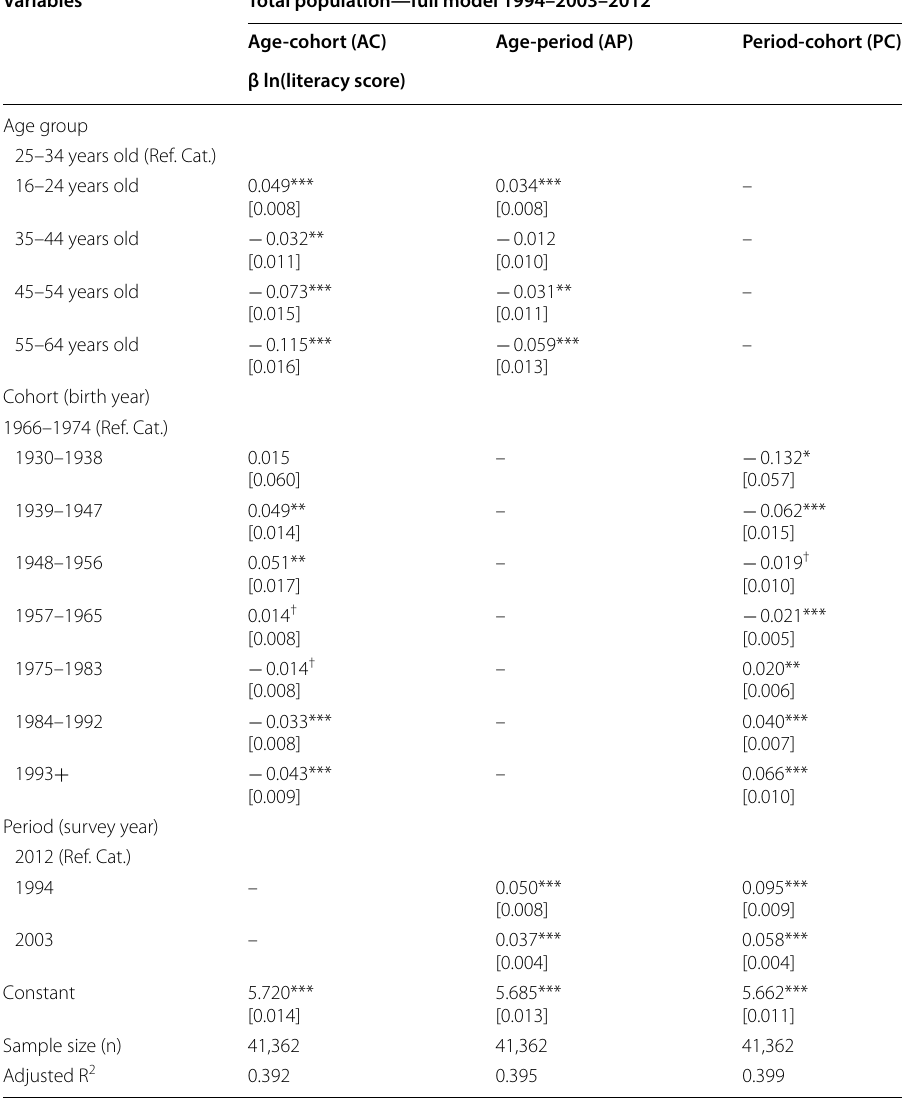
Table 6 Weighted linear regression of the natural logarithm of the literacy score, Canada, 1994 IALS, 2003 ALL and 2012 PIAAC data combined (full model—with all control variables and alternating age, period and cohort